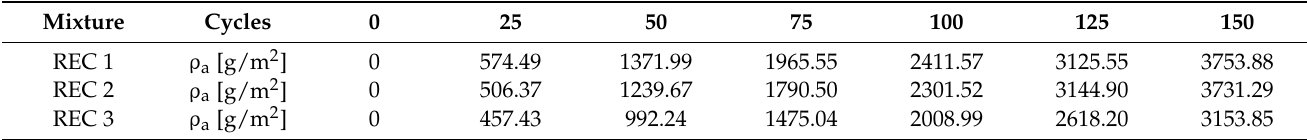
Table 11. Conversion of weight loss per area after each 25 cycles of scaling